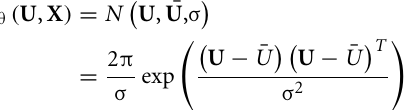
mechanism works with basal ganglia as a RL functionality. Sensor neurons are different types of neurons which get information from different sensors of the robot (middle). Middle:The NAO robot. Arrows indicate the connection between the controller and the robot. Right: the software architecture. Naoqi is working as a middleware to handle the communication of three modules.The communicative information between every two modules are listed above the